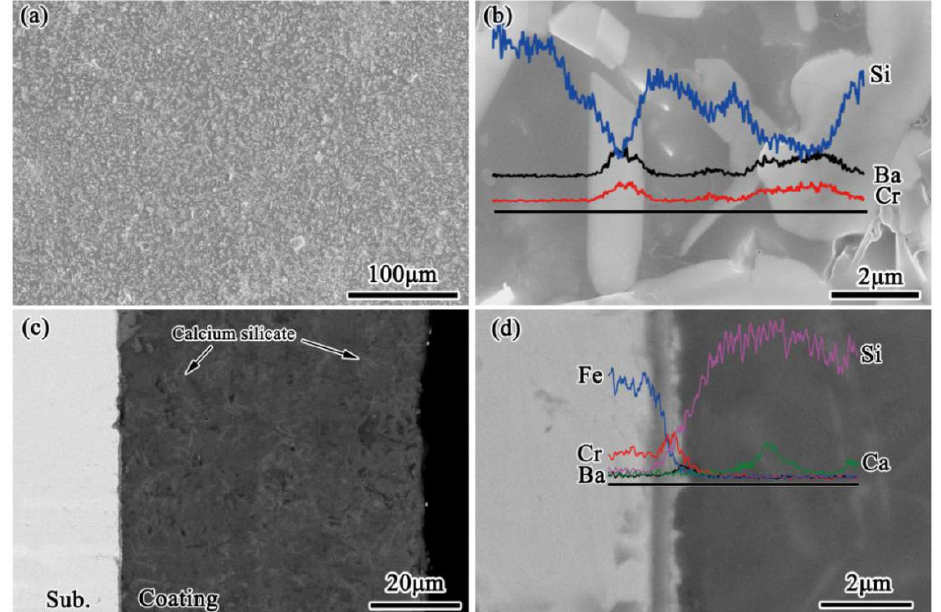
Figure 6. Low-magnification morphology ( a ), high-magnification surface image ( b ), low-magnification cross-sectional image ( c ), and high-magnification cross-sectional image ( d ) of the MSS with GCC after 100 h oxidation at 650 °C.